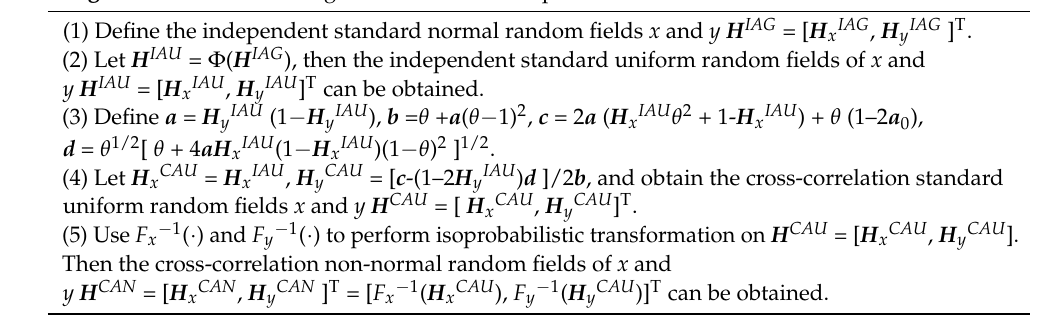
Algorithm 3 Simulation algorithm of Plackett copula-based